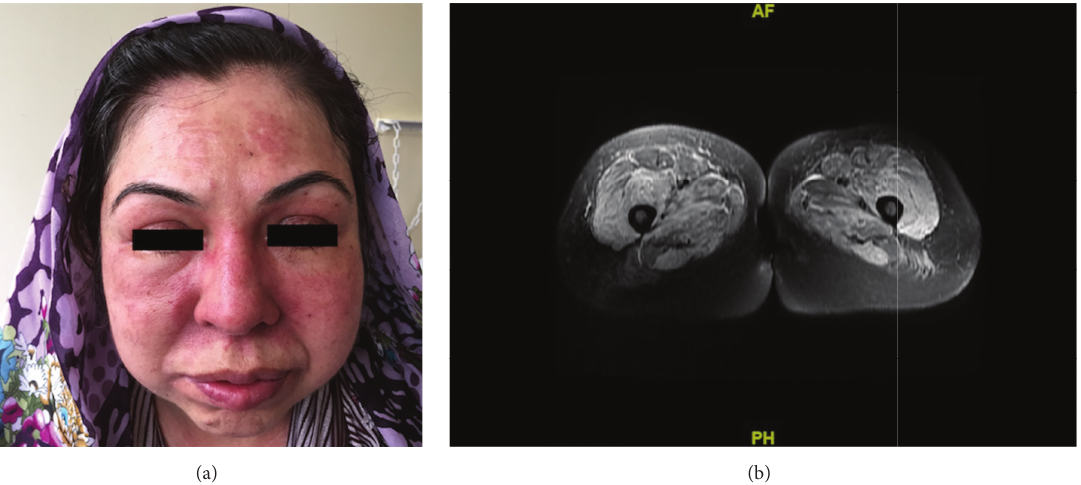
Figure 1: Skin and muscle involvement: (a) rash on her face and (b) bilateral diffuse inflammation in thigh muscles (magnetic resonance